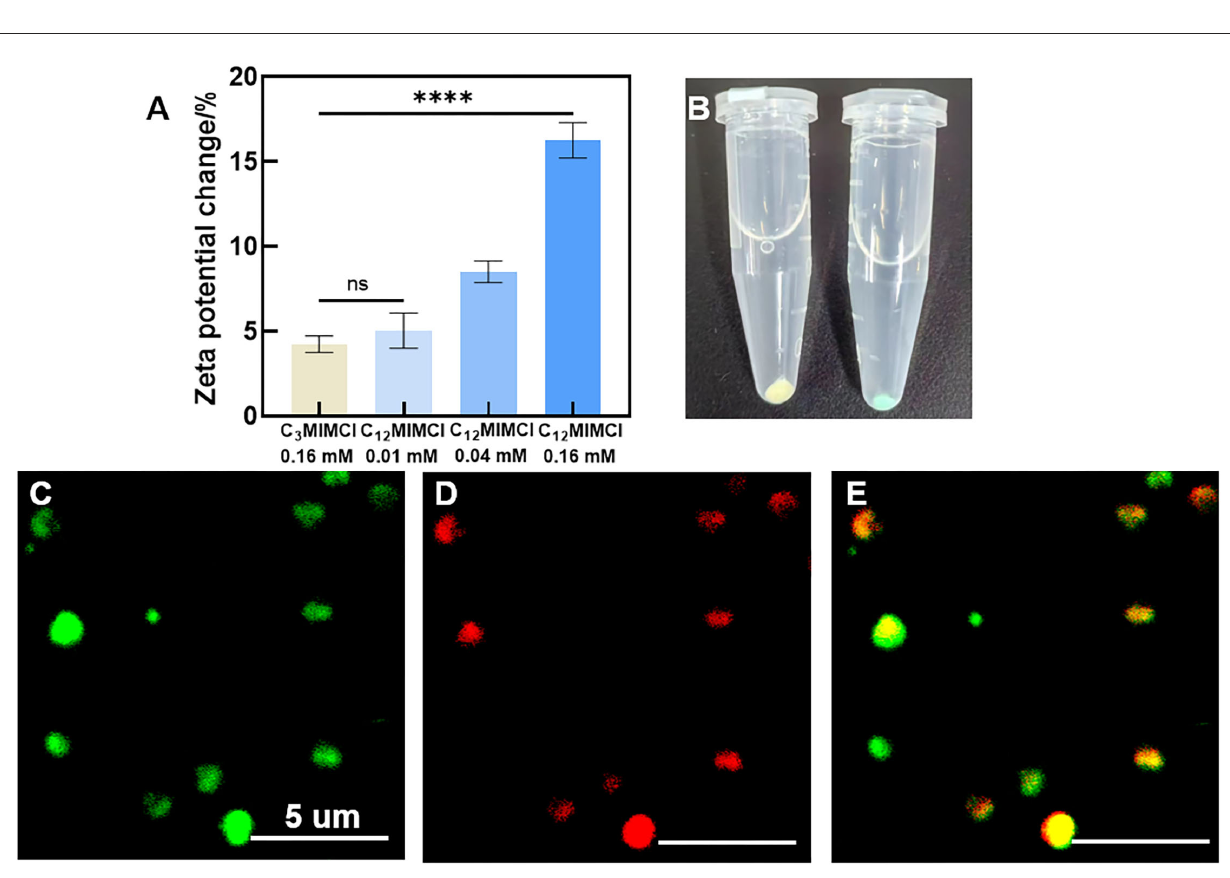
membrane potential increased. The potential of S. aureus is in full correlation with their EC50 values and is concentration